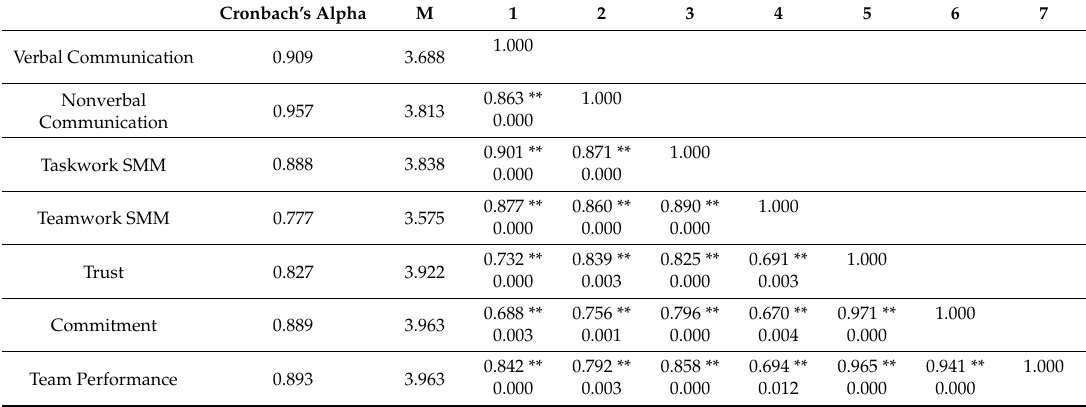
Table 3. Spearman’s rho intercorrelations among